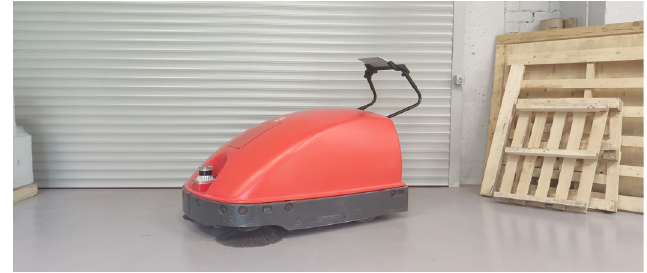
Fig. 1. The built prototype of an industrial floor cleaning